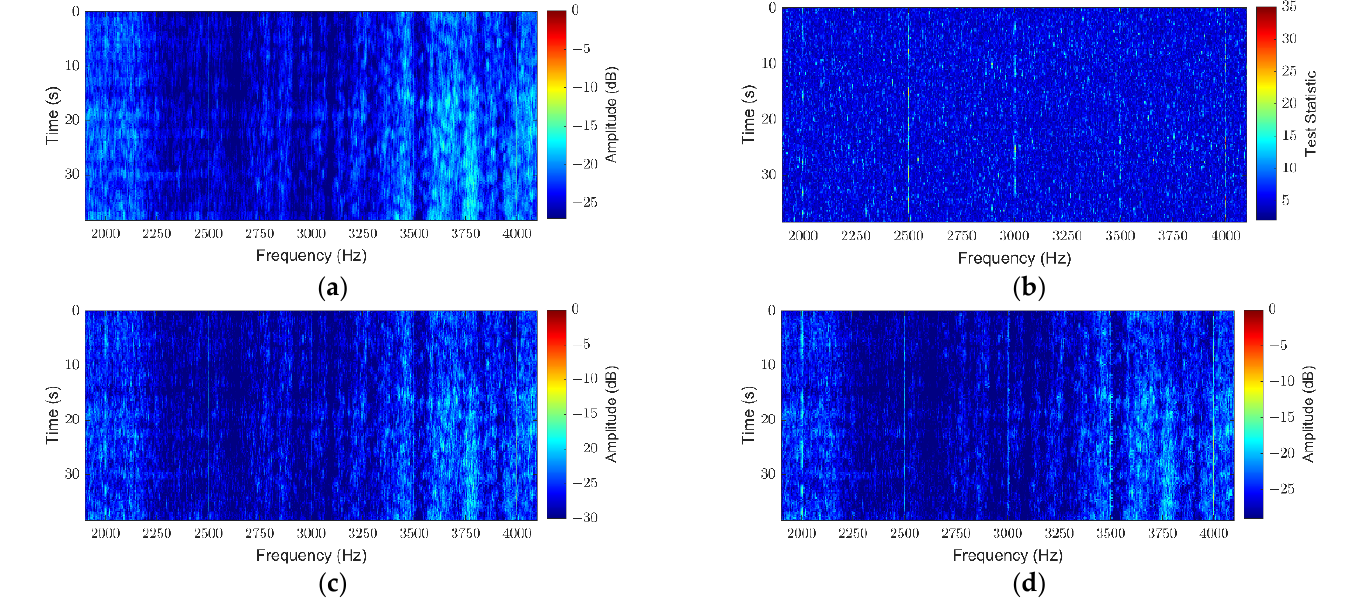
Figure 5. Experimental LOFAR of: ( a ) AVGPR; ( b ) CGLRT; ( c ) CAPSE and ( d ) FJ_CAVGPR.